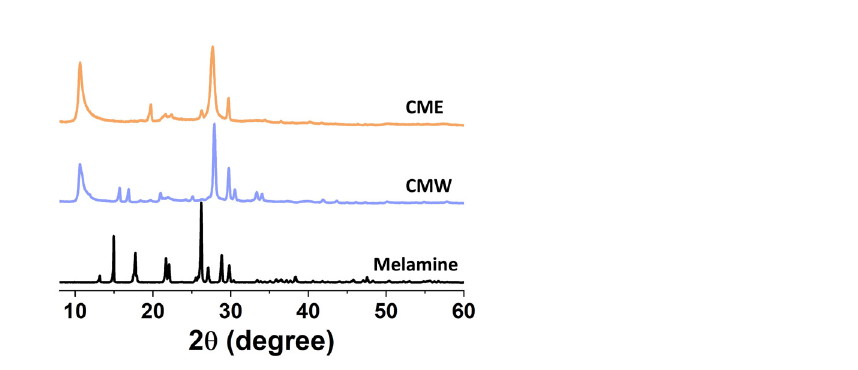
Figure 1. XRPD (X ray Powder Diffraction) pattern of the supramolecular structures synthetized starting from a mixture of melamine and cyanuric acid in water (CMW, light-blue line) and ethanol (CME, yellow line) and XRPD pattern of pure melamine.